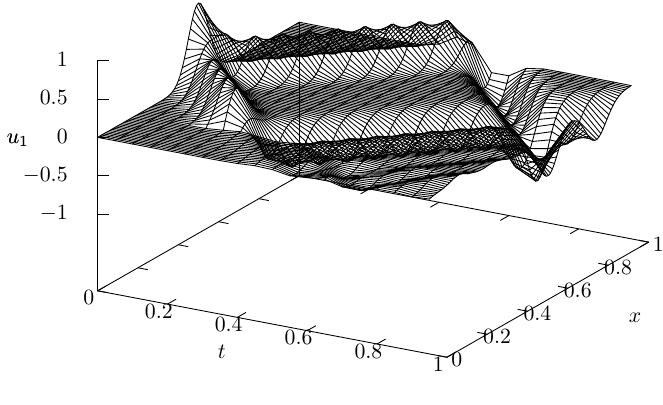
Figure 2. The numerical solution of the wave in Equation (87) without the damping terms. The waves are partly reflected at the connecting point x = x 1 =